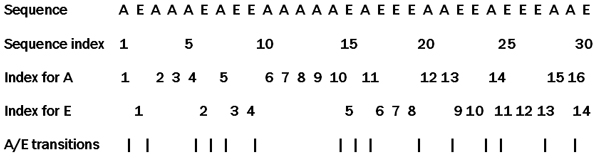
The sequence of a hypothetic protein for illustration of derivation of the feature vector of a protein. Sequence index indicates the position of an amino acid in the sequence. The index for each type of amino acids in the sequence (A or E) indicates the position of the first, second, third, ... of that type of amino acid (The position of the first, second, third, ..., A is at 1, 3, 4, ...). A/E transition indicates the position of AE or EA pairs in the sequence.